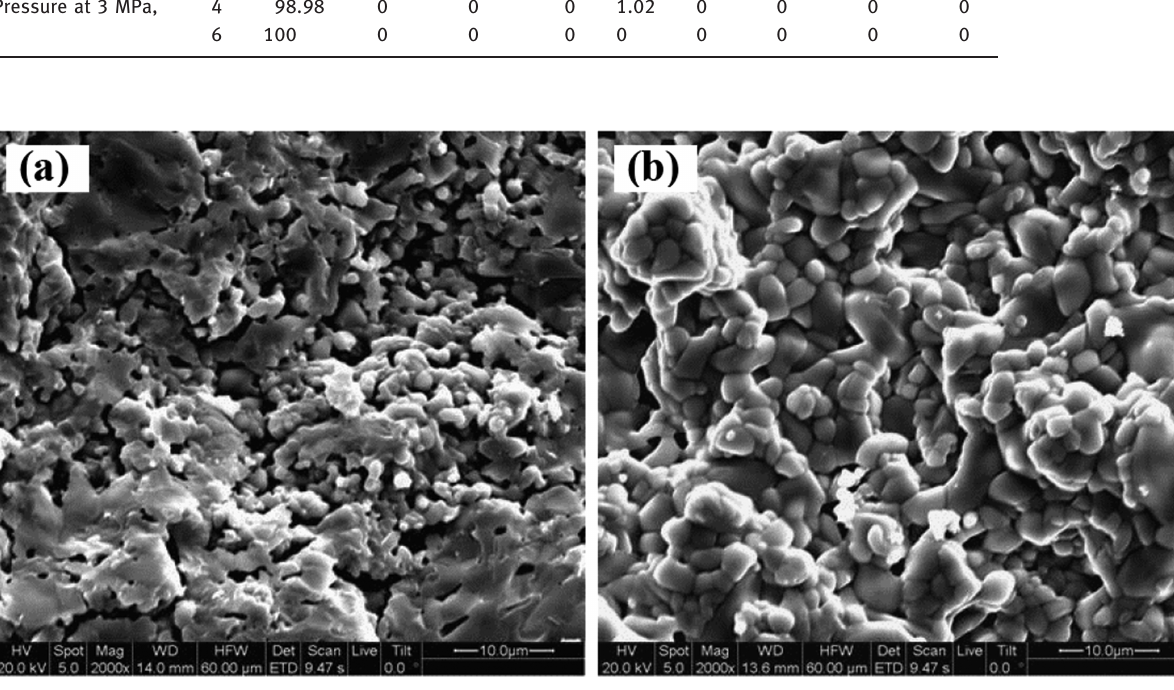
Pressure at  MPa,